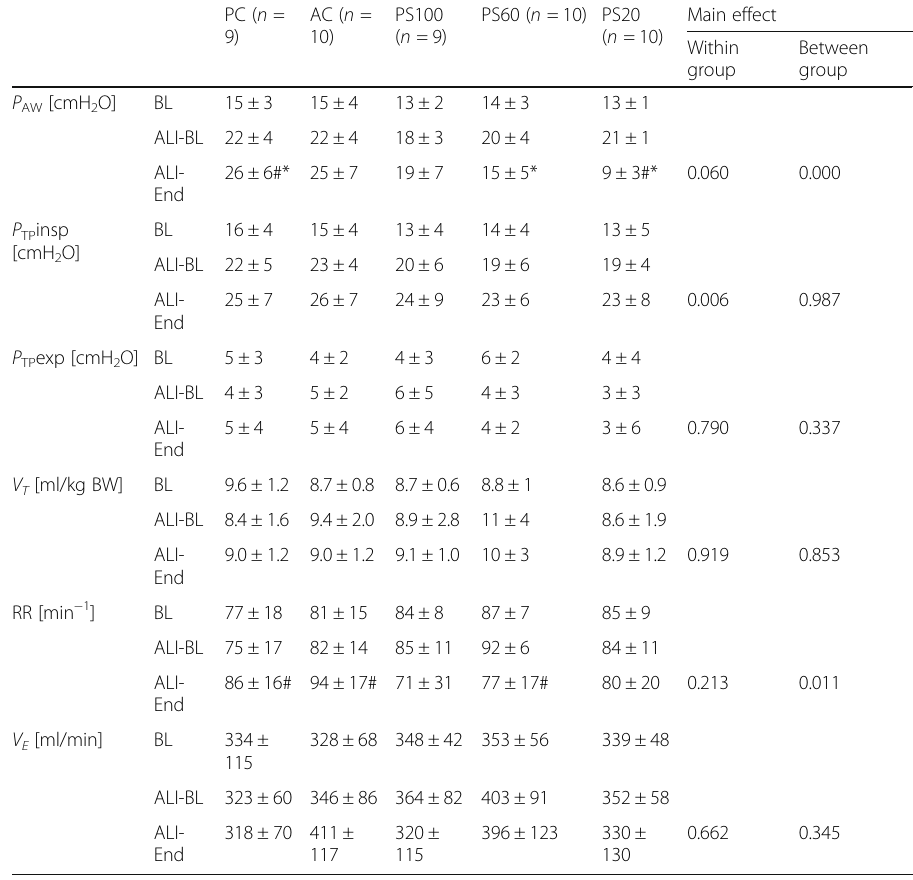
BL baseline measurement on pressure controlled ventilation, ALI-BL measurement on pressure-controlled ventilation after induction of lung injury, ALI-End last measurement after 2 – 4h of experimental ventilation mode, P AW peak airway pressure, P TP i peak inspiratory transpulmonary pressure, V T tidal volume, RR respiratory rate, V E minute ventilation, * p < 0.05 vs. other groups # p <0.05 vs.